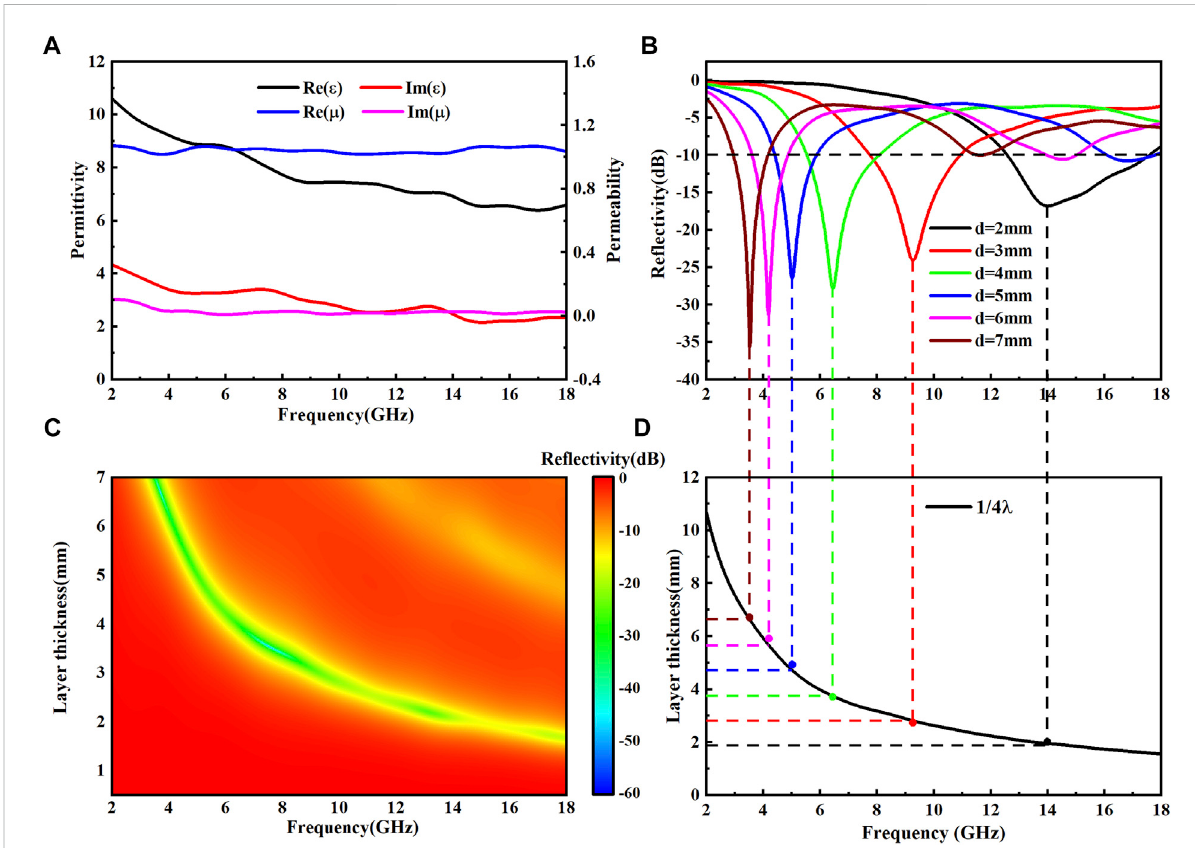
FIGURE 2 (A) The frequency dependence of permittivity and permeability for CB-ABS composite; (B) The distribution map of the RL curves for the single layer composites with thickness and frequency; (C) RL curves with different thicknesses; (D) calculated curve of thickness versus peak frequency under λ /4